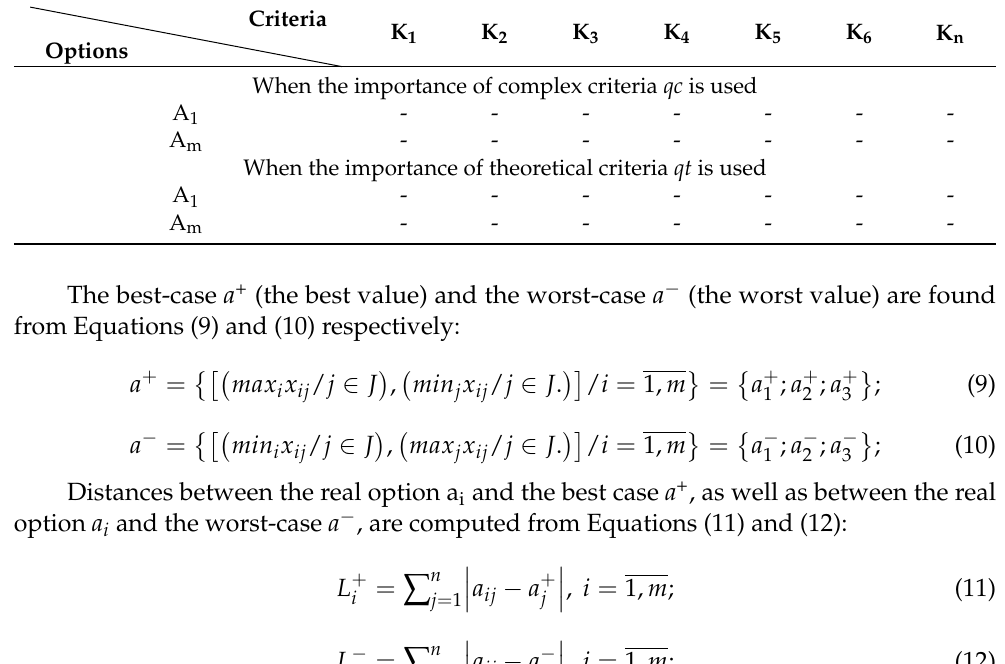
Table 15. Weighted normalized Matrix M * of alternative solutions.